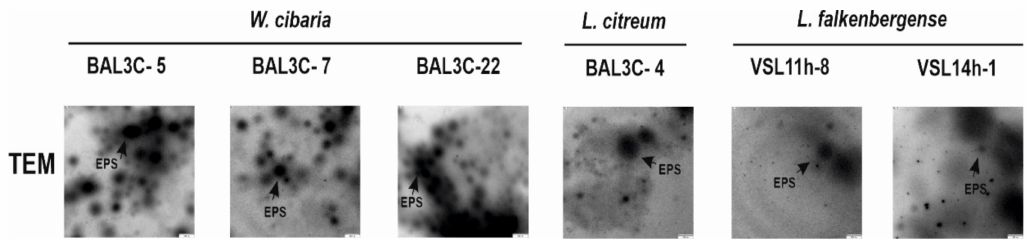
Figure 4. Detection by TEM of the EPS production by LAB. Pictures of the EPS present in samples from LAB colonies after 48 h of growth in